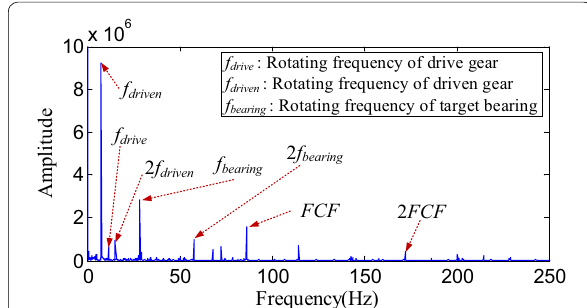
Figure 1 Envelope spectrum of faulty bearing signal with gearbox interference